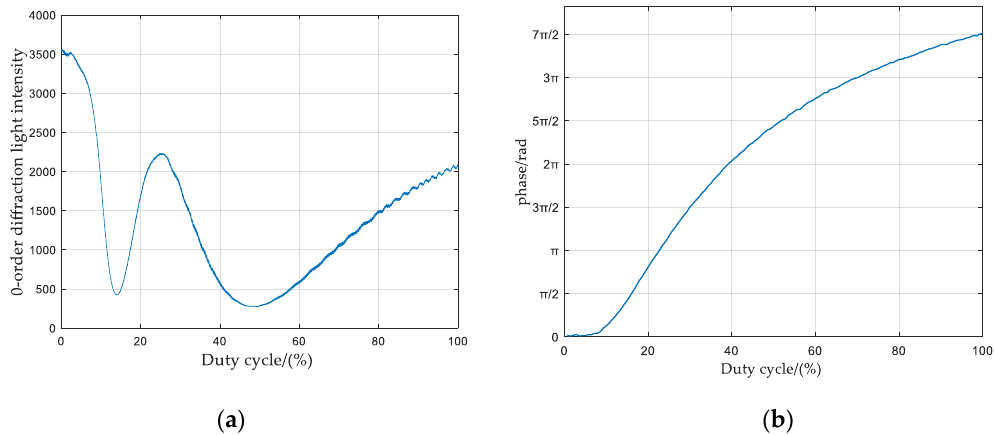
Figure 6. Phase modulation characteristics of ( a ) light intensity with duty cycle and ( b ) modulation phase with duty cycle.